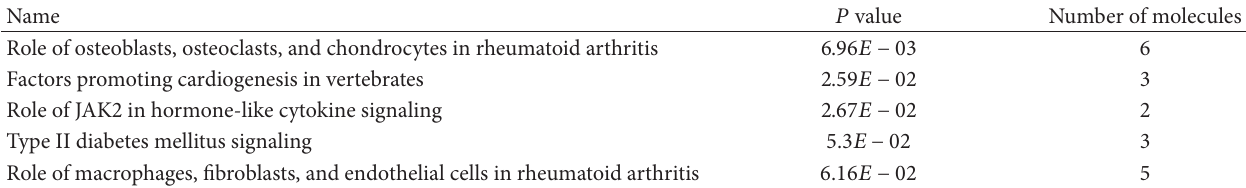
Table 5: Top canonical pathways associated with differentially expressed genes between the RDE-H group and OVX group.